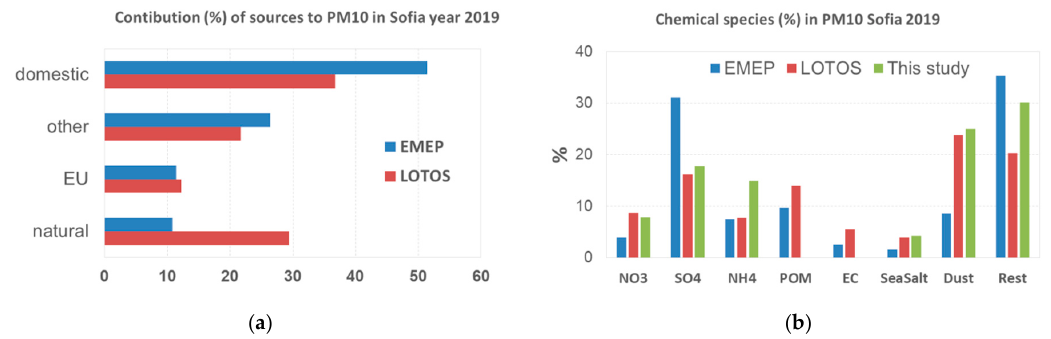
Figure 7. Contribution ( a ) and chemical species ( b ) in PM10 for Sofia, 2019.